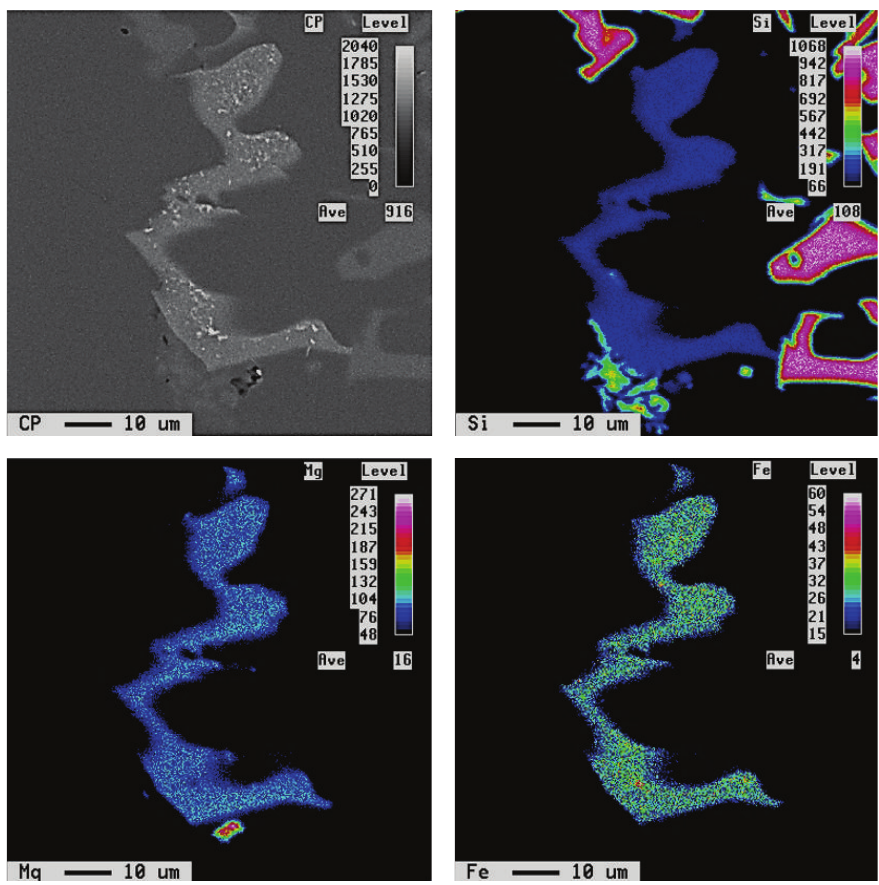
Figure 5: Element distribution in 𝜋